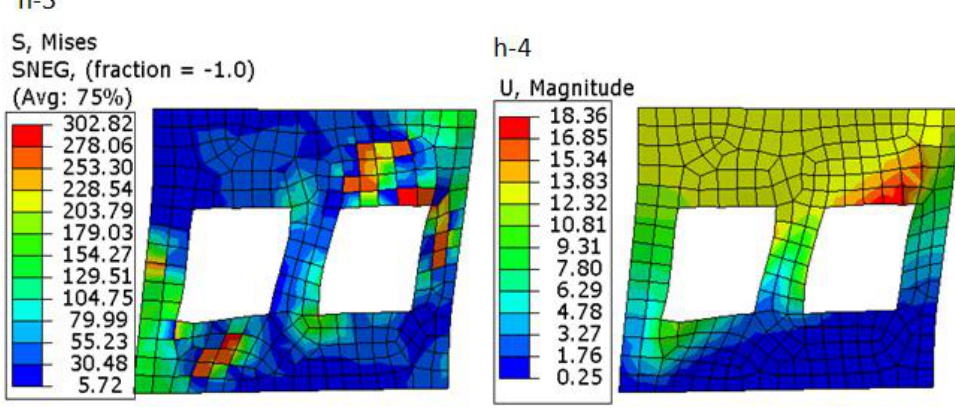
Figure 24. Von Mises stress for shell part (h-1) frame part and (h-2) steel plate.